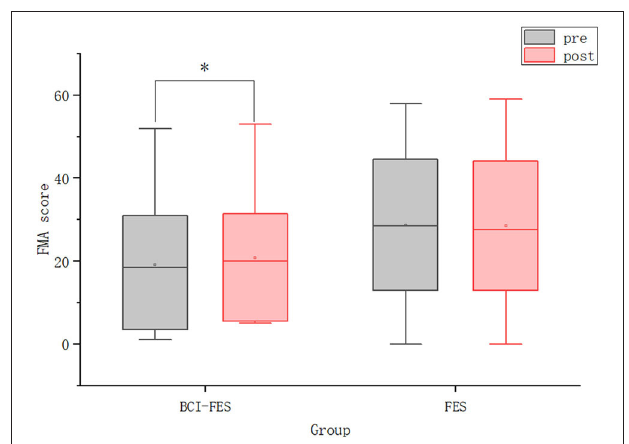
FIGURE 4 | The FMA scores of patients in the two groups before and after the intervention. Hollow squares represent mean values. * p <